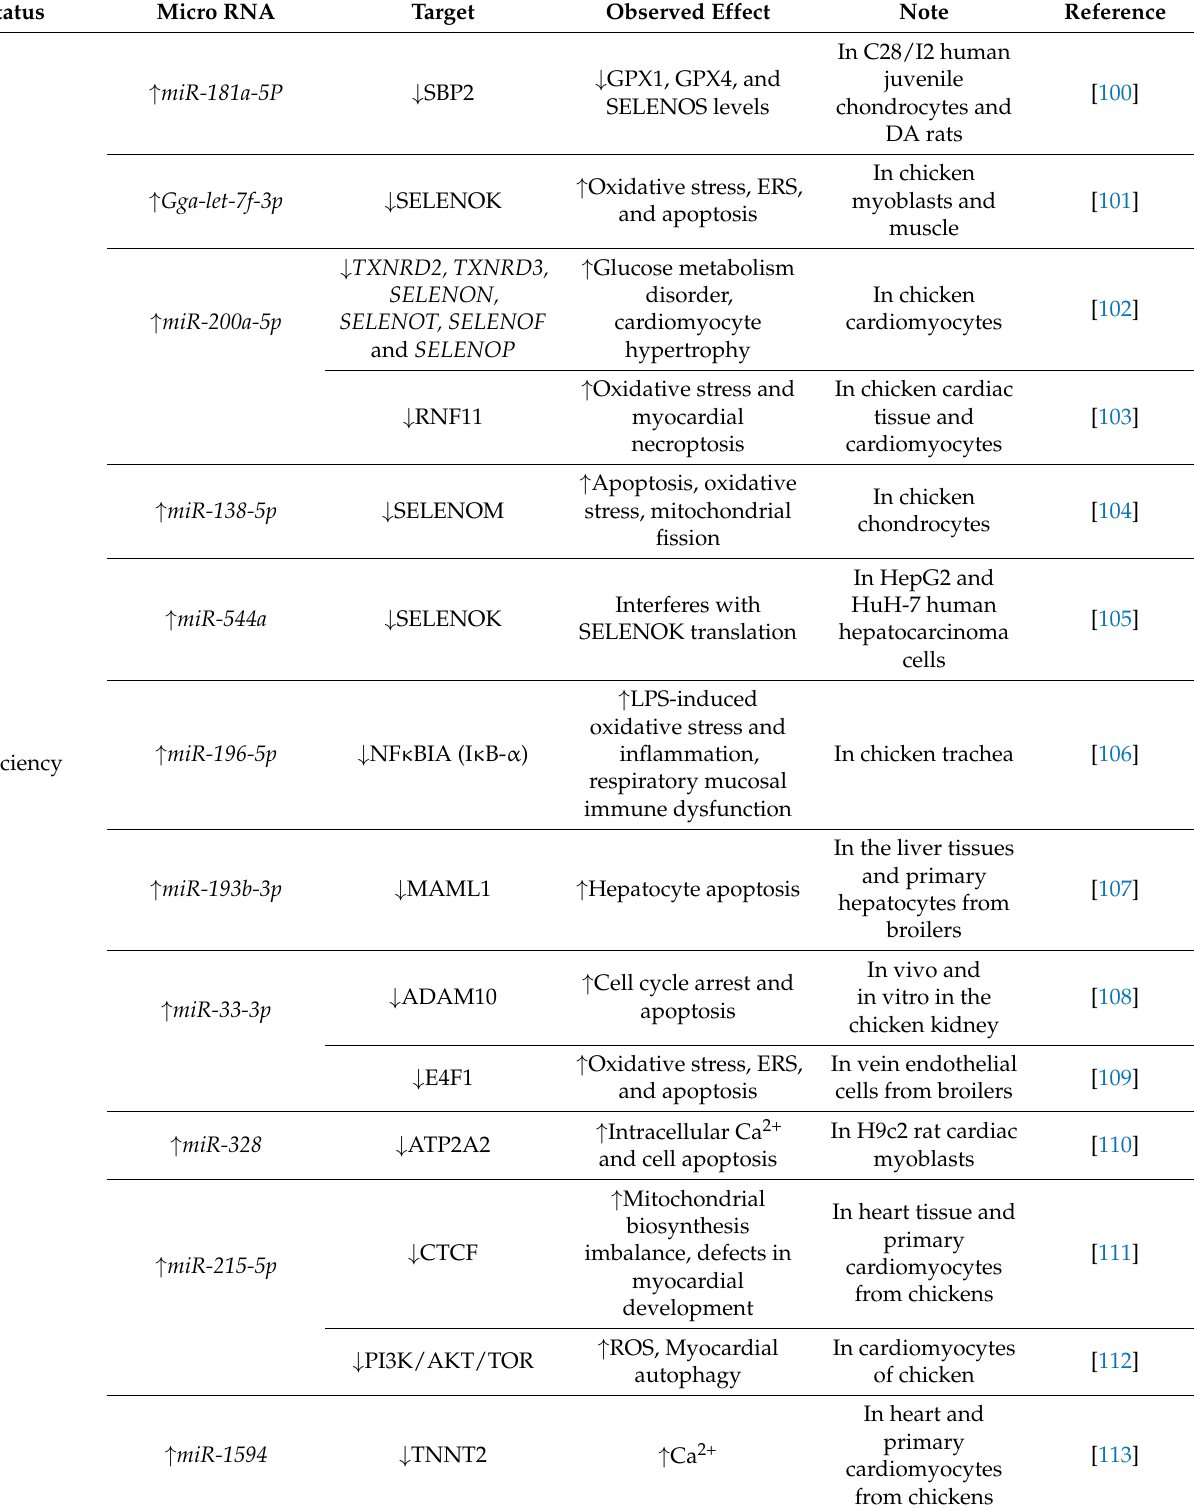
Table 1. MiRNAs are regulated by selenium (deficiency, moderate, and